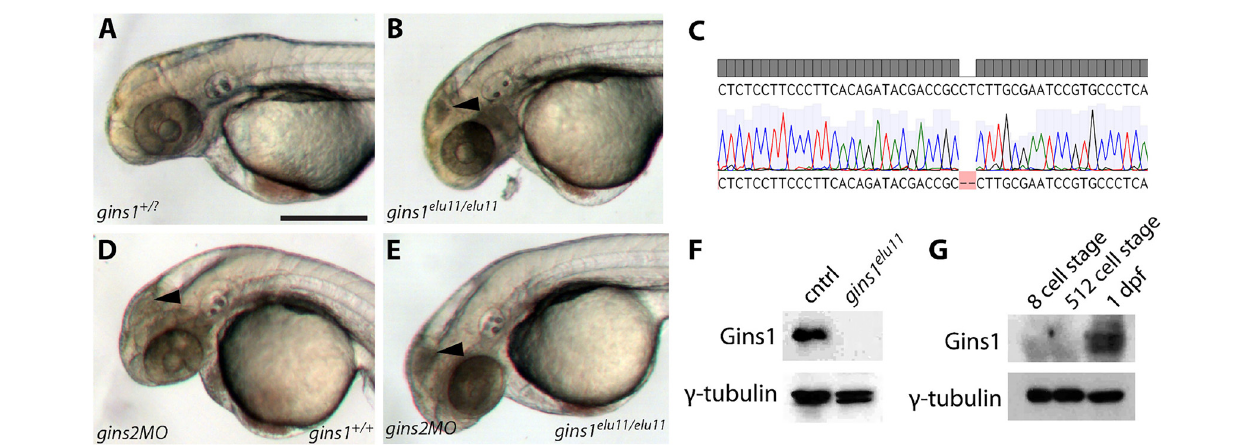
FIGURE 4 | Gins1 deficient and Gins1, Gins2 double-deficient embryos show comparable cell death phenotypes in eyes and tecta. (A,B) The gins1 elu11 frameshift allele created through genome editing shows retinal and tectal apoptosis at 2 dpf, similar to other CMG mutants. (C) Sanger sequencing of gins1 elu11 / elu11 embryos shows the presence of the homozygous c.250_251delCT mutation. (D,E) Phenotype of gins1 mutant embryos and their siblings injected with 100 µ M gins2 MO. (F) Western blot analysis of protein lysates from 2 dpf control and gins1 elu11 / elu11 embryos probed with Gins1 and γ -tubulin antibodies. (G) Western blot analysis of protein lysates from wildtype embryos at the indicated stages probed with Gins1 and γ -tubulin antibodies. Scale bar: 250 µ